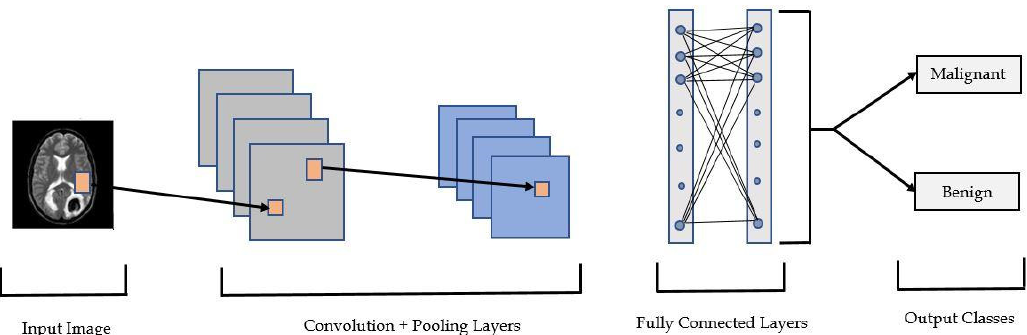
Figure 2. Convolution Neural Network for Tumor Image Classification.